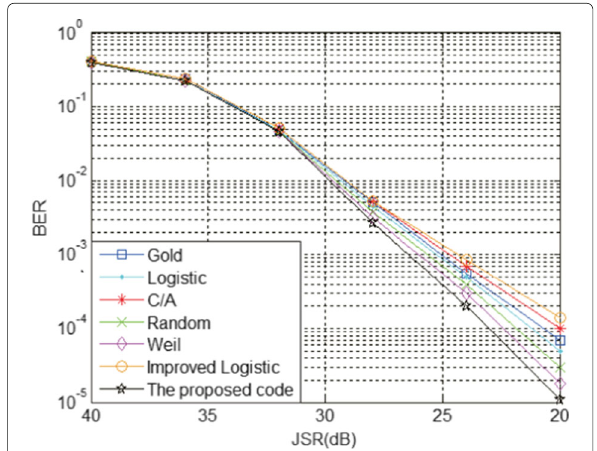
Fig. 11 BER curve of ranging codes with JSR under noise PM